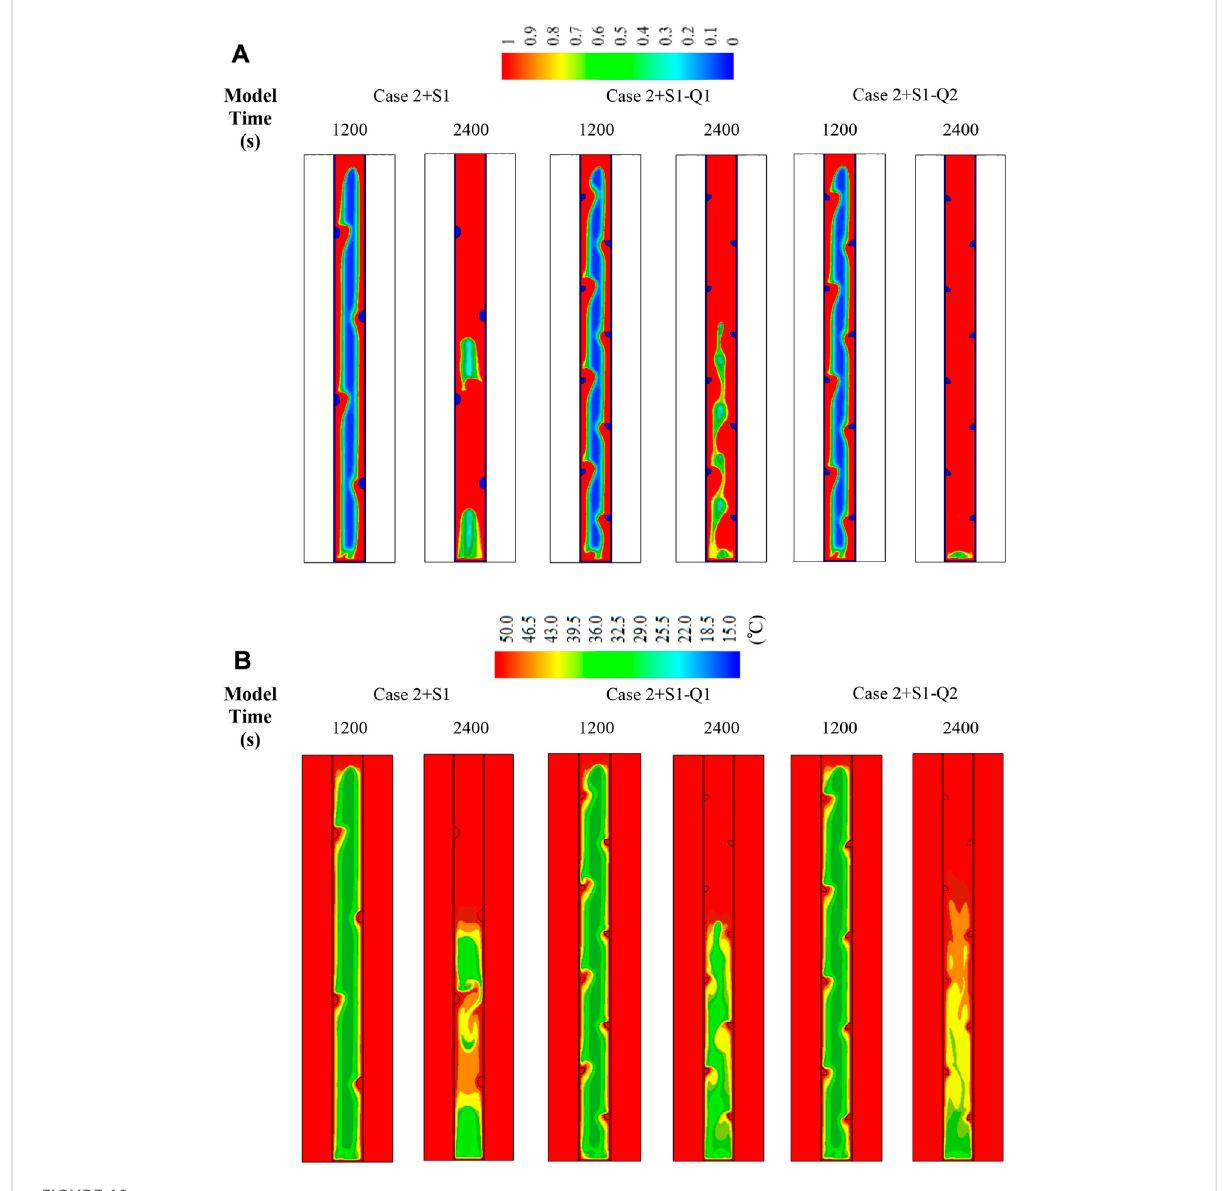
FIGURE 10 (A) Liquid fractionand (B) temperaturecontours ofthePCMfor fourhemispherical fi ns (Nequals4) andupwardanddownwardcurveviewwith left-staggered fi ns and an added fl at fi n to the base of the PCM domain for all the